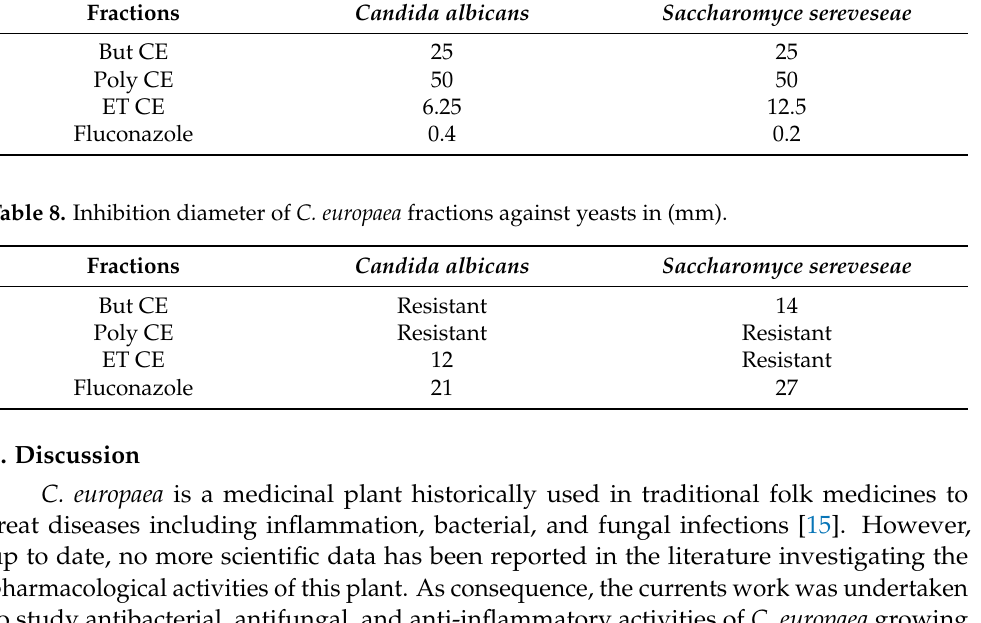
Table 7. MCI of C. europaea fractions against yeasts in (mg/mL). Fractions